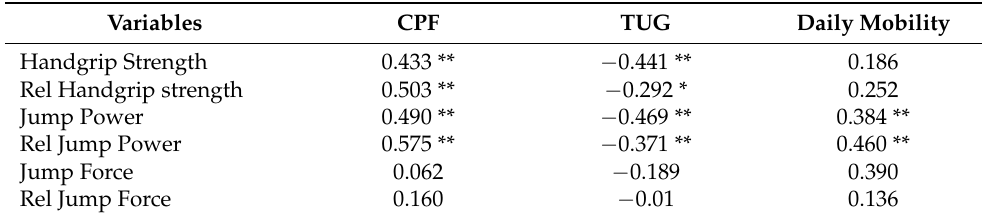
Table 2. Associations between musculoskeletal fitness and physical functioning (activities of daily living—ADL, walking speed (TUG time), habitual daily mobility). Variables CPF TUG Daily Mobility Handgrip Strength 0.433 ** − 0.441 ** 0.186 Rel Handgrip strength 0.503 ** − 0.292 * 0.252 Jump Power 0.490 ** − 0.469 ** 0.384 ** Rel Jump Power 0.575 ** − 0.371 ** 0.460 ** Jump Force 0.062 − 0.189 0.390 Rel Jump Force 0.160 − 0.01 0.136 Note: * p < 0.05; ** p < 0.001.